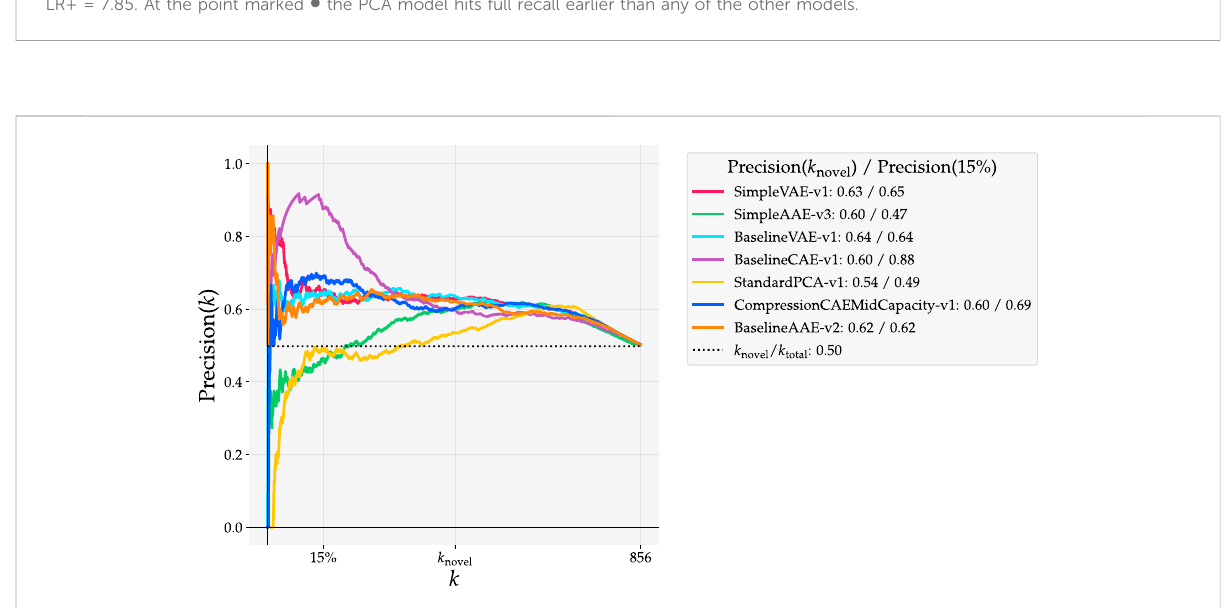
FIGURE 9 Precision( k ) curves for reconstruction-based detections with models trained on Curiosity Mastcam. k novel = 430 is the number of ground truth novel samples in the dataset and 15% of the data accounts for 128